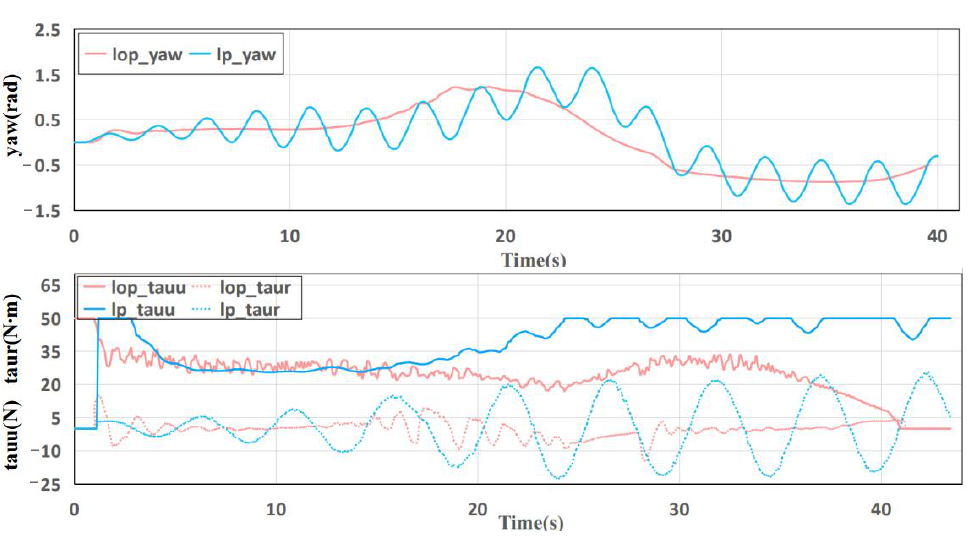
Figure 9. Execution state comparison of motion tracking